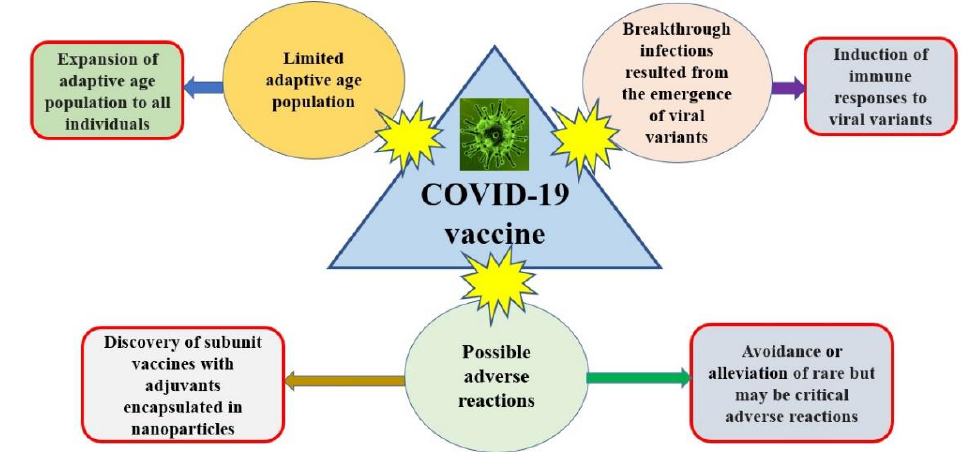
Figure 1. Impact of COVID-19 vaccines and development of next-generation vaccines.